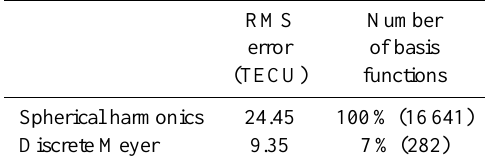
Table 2. RMS error (values are in TECU) of the VTEC map ob- tained with spherical harmonics and discrete Meyer with a noise term added to the observations. Only the VTEC coefficients where there is ray coverage were considered. The percentage of basis func- tions with non-zero coefficients is also shown and, within brackets, the number in absolute